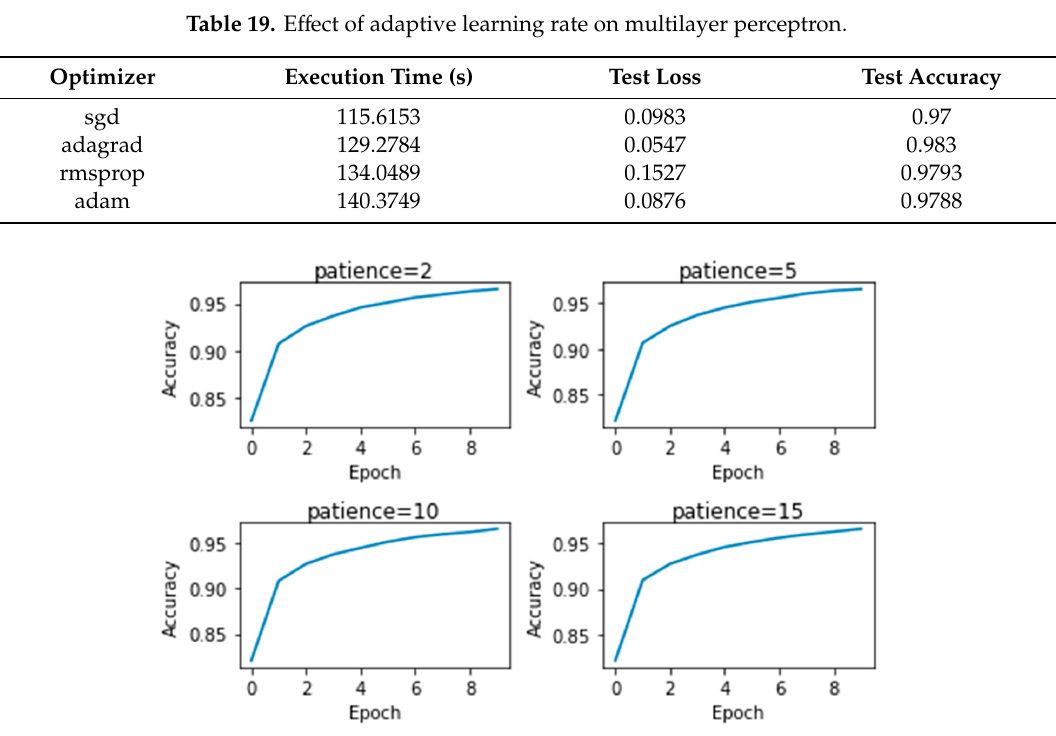
Table 20. Effect of learning rate on SNN. Table 20. E ff ect of learning rate on